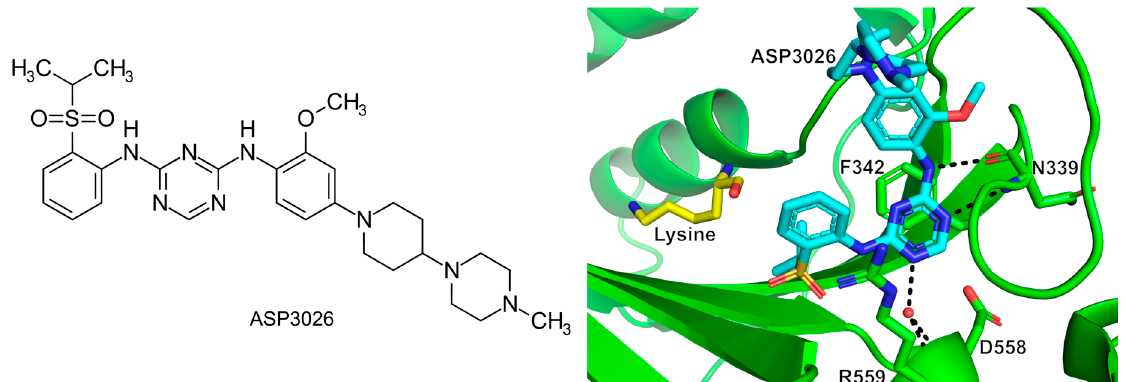
Figure 6. Structure of ASP3026 targeting the active site of Pf-LysRS. Left: Chemical structure of ASP3026; Right: Ternary structure of P. falciparum LysRS in complex with ASP3026 and lysine (PDB entry: 7BT5). The protein backbone is shown as a cartoon representation (green) while ASP3026 (cyan C-atoms), lysine (yellow C-atoms), crucial protein residues for binding, and a structured water molecule (red) are shown as sticks and a sphere, respectively. H-bond interactions are shown as black dashed lines.